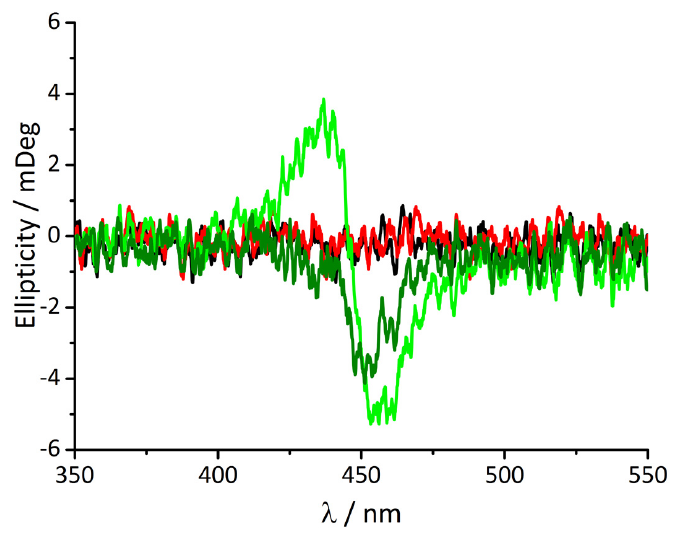
Figure 4. CD spectra of t-H 2 Pagg no salt added (black curve), t-H 2 Pagg aggregates (red curve), after addition of HSA at t = 0 s (light green curve) and at t = 60 min (dark green curve). Experimental conditions: [tH 2 Pagg] = 5 µ M, [NaCl] = 100 mM, [HSA] = 100 µ M, phosphate buffer 1 mM, pH = 7.4, T = 298 K.